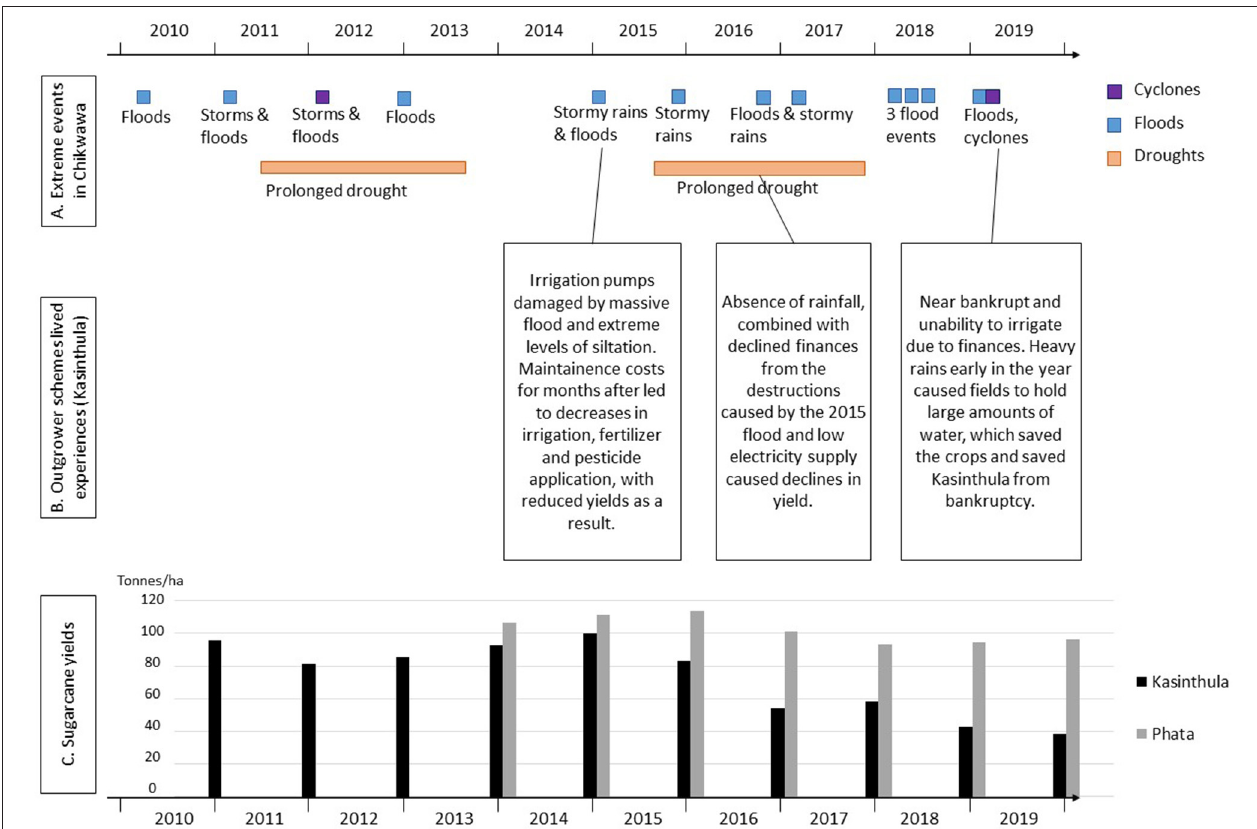
FIGURE 1 | Timeline over (A) the occurrence of extreme events (droughts, cyclones, storms, and floods) during 2010–2019 in the Chikwawa District (sources: ReliefWeb, PreventionWeb, EM-DAT, Government of Malawi, 2015b, 2016, 2019), (B) The lived experiences of the effects of extreme events by Kasinthula managers (Phata managers stated there were no, or marginal effects) (source: interviews), (C) Sugarcane yields, Phata, and Kasinthula schemes (obtained from scheme